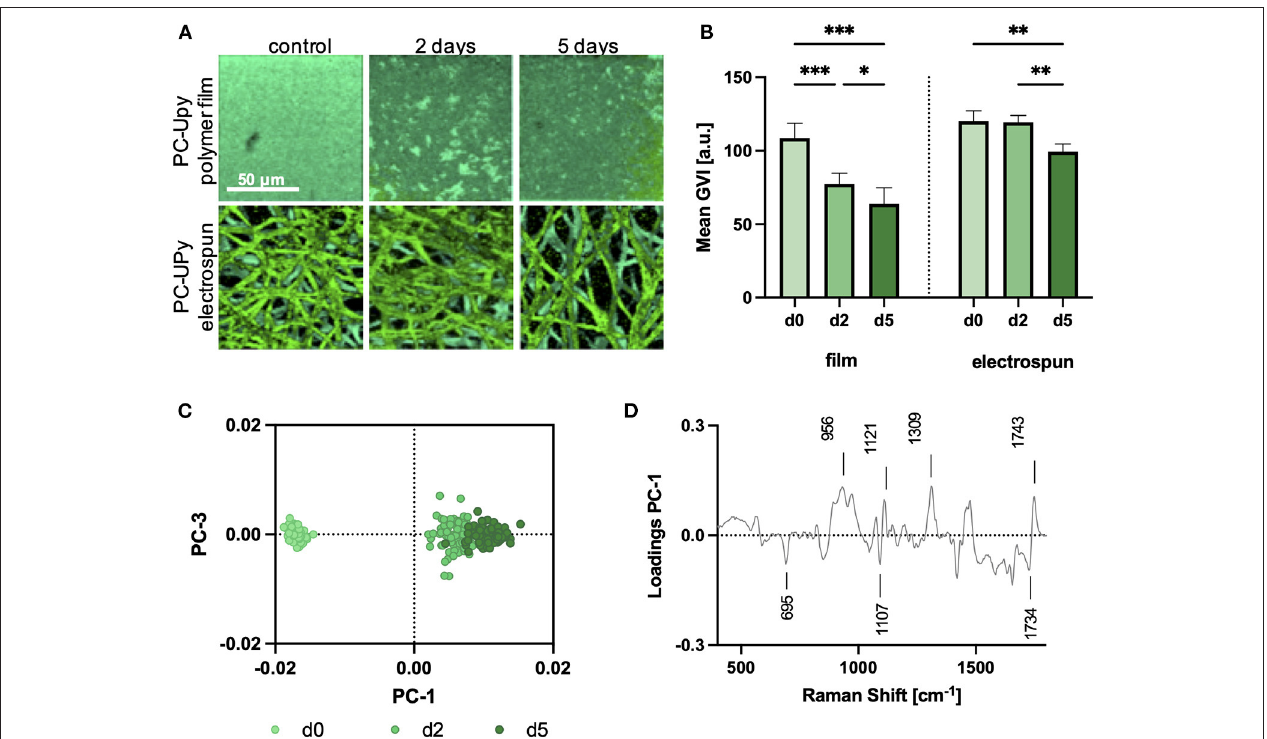
FIGURE 4 | Comparison of oxidative in vitro degradation of film and electrospun PC-UPy polymers. (A) TCA images of polymer films (upper row) and electrospun scaffolds (lower row) at 0 (d0), 2 (d2) and 5 (d5) days of oxidative in vitro degradation. Scale bar equals 50 µ m (B) Mean gray value intensities (GVI) of the PC-UPy polymer film and electrospun fiber intensity distribution heatmaps. Data are represented as mean ± SD; n = 3, one-way ANOVA, * p < 0.05, ** p < 0.01, *** p < 0.001. (C) PC-1/PC-3 scores plot of a PCA performed on single extracted spectra from electrospun fibers (A) demonstrates a degradation time-dependent shift in the Raman signature. (D) The PC-1 loadings plot indicates relevant peaks for the spectral